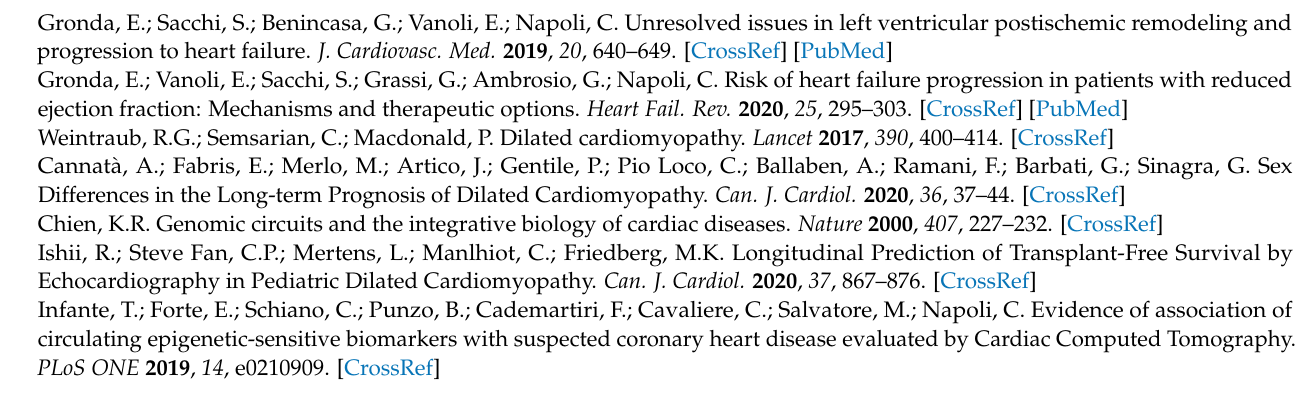
genes; Table S5: Gene Ontology Biological Process for under-expressed genes; Table S6: Gene Ontology Molecular Function for under-expressed genes; Table S7: Correlation analysis between DCM-related genes with clinical and echocardiographic parameters in function of severe functional status (NYHA-class